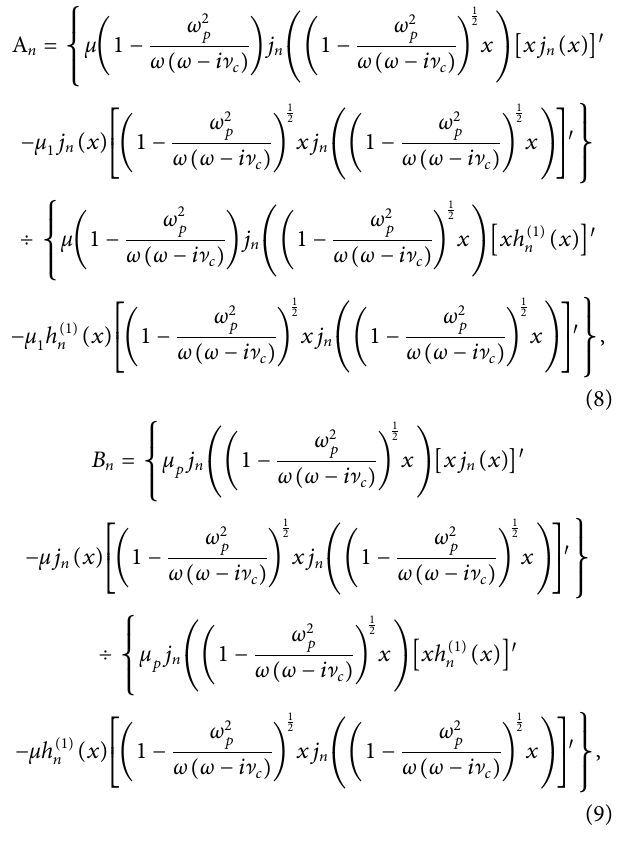
Frontiers in Physics |